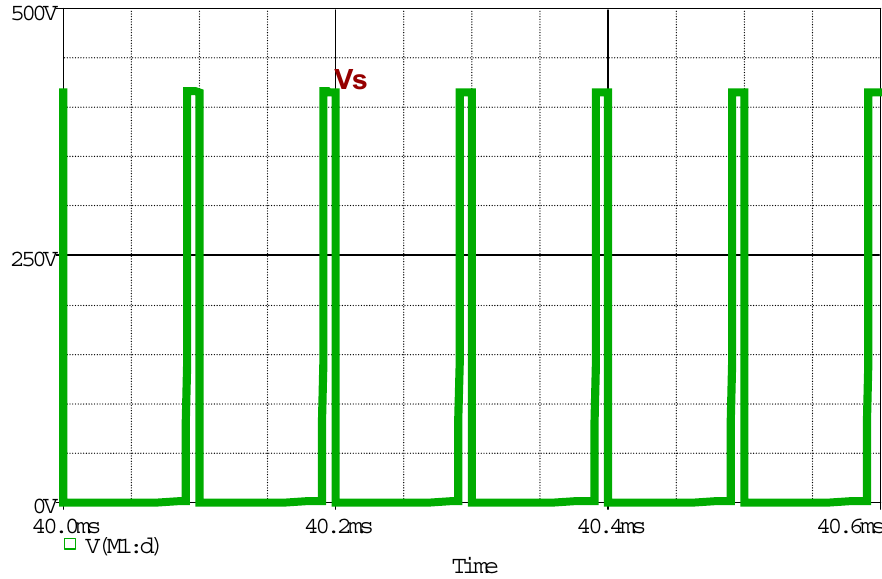
Figure 29. Voltage across switch “s” of the conventional boost converter [28].